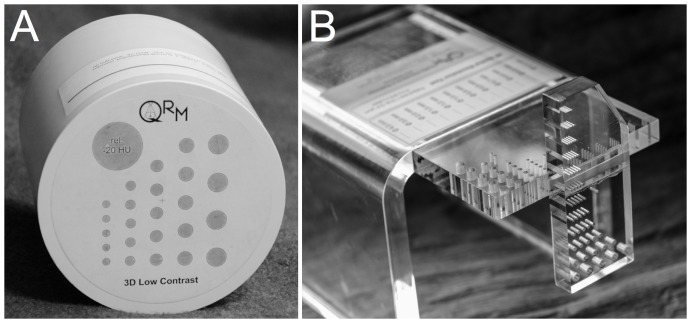
Photograph of the 3D low-contrast phantom (a) and the 3D spatial resolution phantom (b).